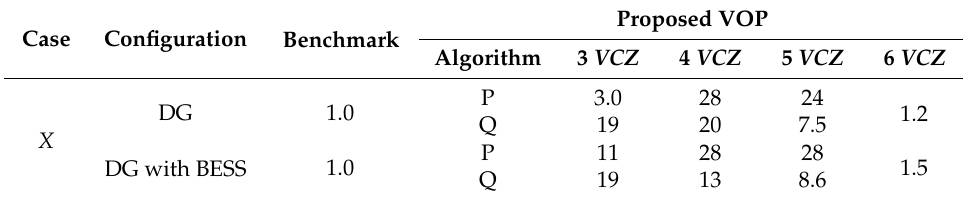
Table 13. Normalized objective functions (p.u.) for Case X